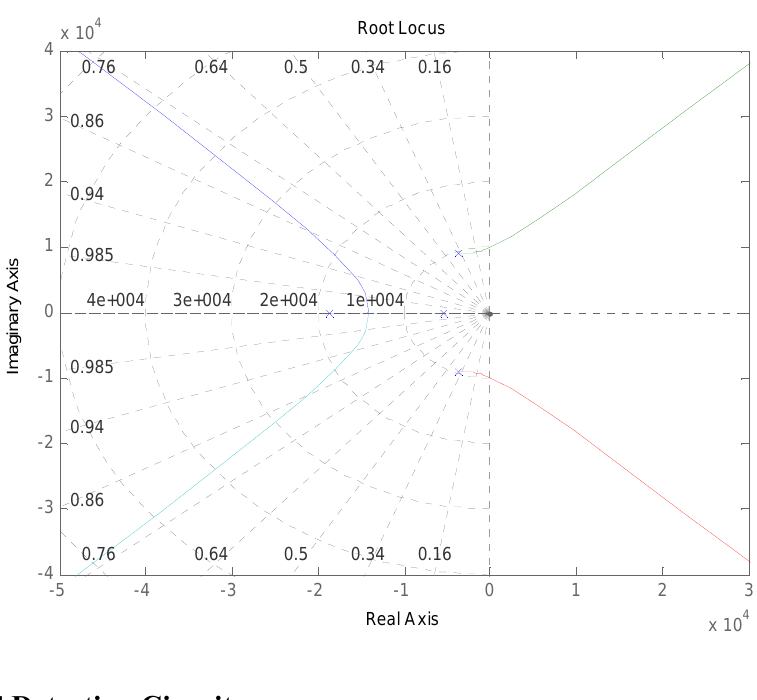
Figure 6. Root locus of accelerometer system